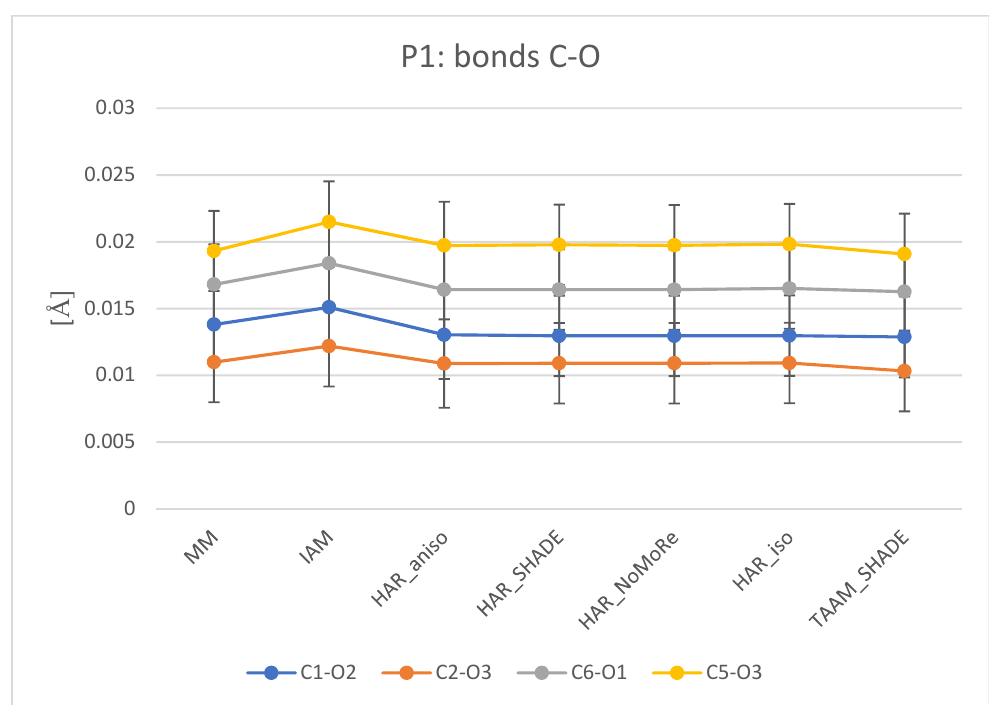
Figure 5. Comparison of the O–C bonds for IAM, MM, HAR, and TAAM refinements of 1 . The values on the plot represent the difference between the analysed model and the neutron data (in Å). Plotlines have no physical meaning, but aid in visual analysis. For each plot, estimated standard deviations within +/ − 1 ESD are included. For comparison, plots of O–C bonds for 2 and 3 are available in the Supplementary Materials (see Figure S8).